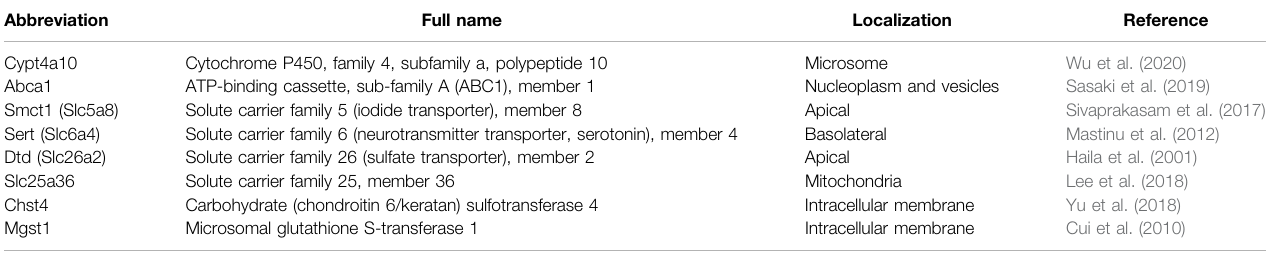
TABLE 1 | Metabolic genes regulated by PPAR- α .